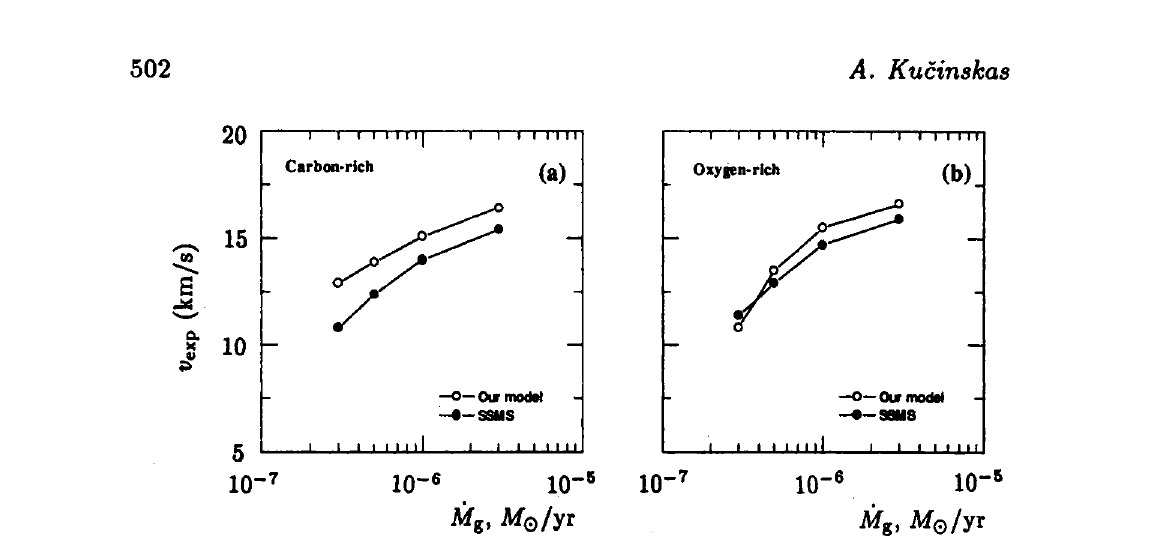
Fig. 1. A comparison of the terminal outflow velocities produced by our model and the model of SSMS for carbon-rich (a) and oxygen-rich (b) AGB stars: (a) model parameters: M* = 1 MQ, L* = 10 4 Lq, T 2000 K, ad = 0.05 p,m, p = 1.85 g/cm 3 , = 0.0015 and T s (amorphous carbon grains are assumed); (b) model parameters: M+ — 1